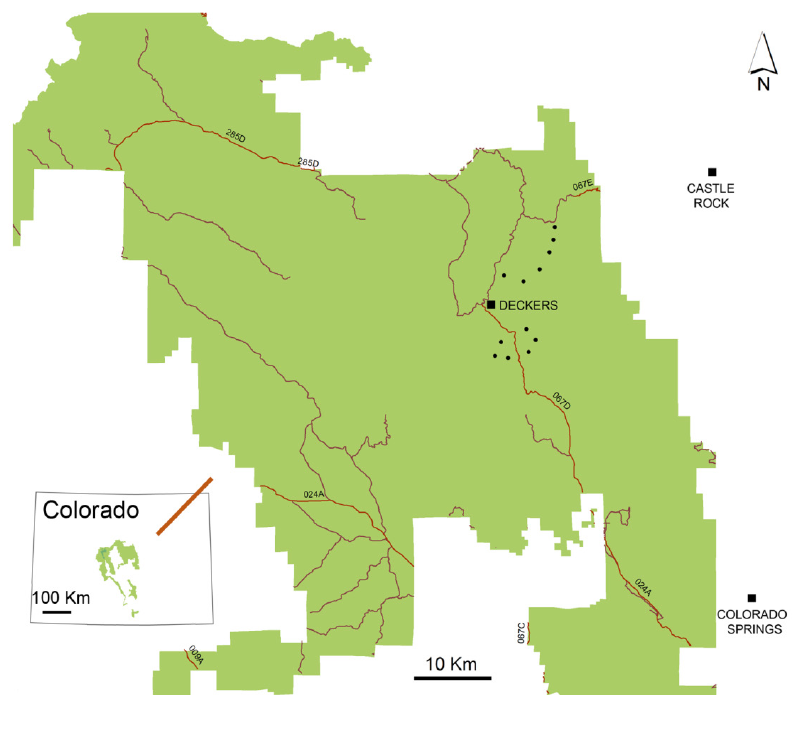
Figure 1. Study site locations in the South Platte Ranger District, Pike-San Isabel National Forest in central Colorado, USA. Red lines indicate roads, black dots indicate plot locations, and green shading represents National Forest